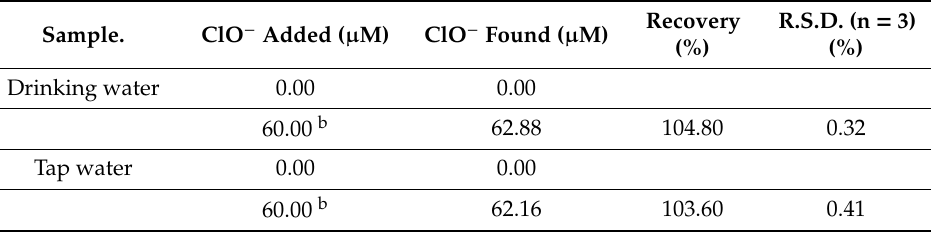
Table 1. Determination of ClO − . a.